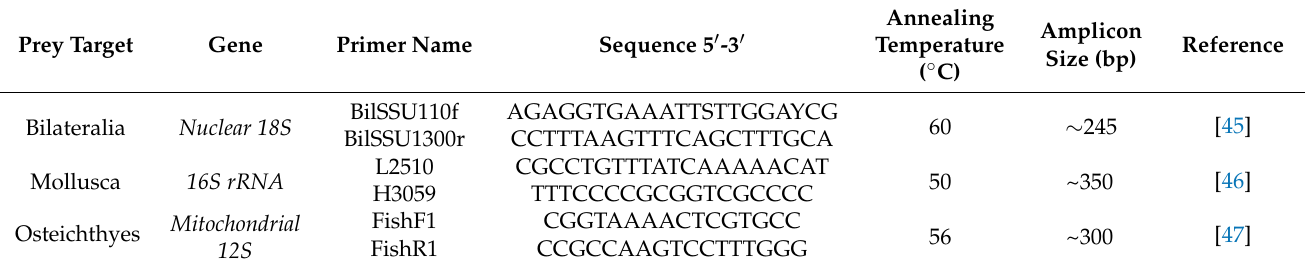
Table 1. List of primers used in this study for the detection of prey species and intestinal parasites in scat samples from Falkland Steamer Duck Tachyeres brachypterus and Crested Duck Lophonetta specularioides